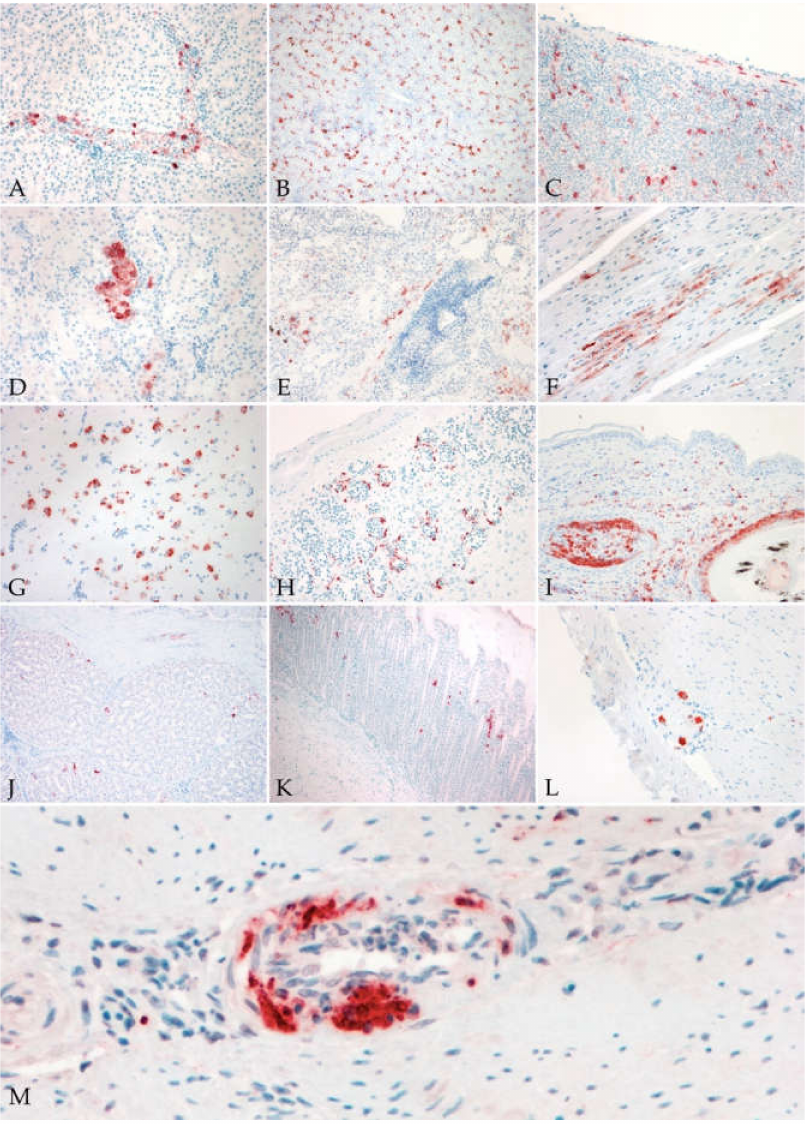
Figure 2. Virus antigen in different tissues of blackbirds naturally infected with USUV. ( A ) Liver: pos- itive intravascular mononucleated cells (20 × ); ( B ) liver: diffuse presence of virus antigen in Kupffer cells and hepatocytes (10 × ); ( C ) spleen: diffuse distribution of virus antigen in mononucleated cells and in smooth muscle and fibroblast of the splenic capsule (10 × ); ( D ) kidney: focal positivity of tubu- lar epithelium (40 × ); ( E ) lung: multifocal positive pneumocytes, mononucleated inflammatory cells and smooth muscle cells of a pulmonary vessel (10 × ); ( F ) heart: focal positivity of cardiomyocytes; ( G ) cerebrum: diffuse positivity of neurons and glial cells (40 × ); ( H , I ) skin: diffuse positivity of endothelial cells ( H ; 20 × ) and positive feather shafts and bulbs ( I ; 20 × ); ( J ) proventriculus: scattered positive mucosal epithelial cells (10 × ); ( K ) gizzard: multifocal areas with positive mucosal epithelial cells (10 × ); ( L ) intestine: positive ganglionic neurons of myenteric plexus (20 × ); ( M ) medium size artery: positive signal in endothelial cells and in the infiltrating inflammatory cells (vasculitis) (40 ×